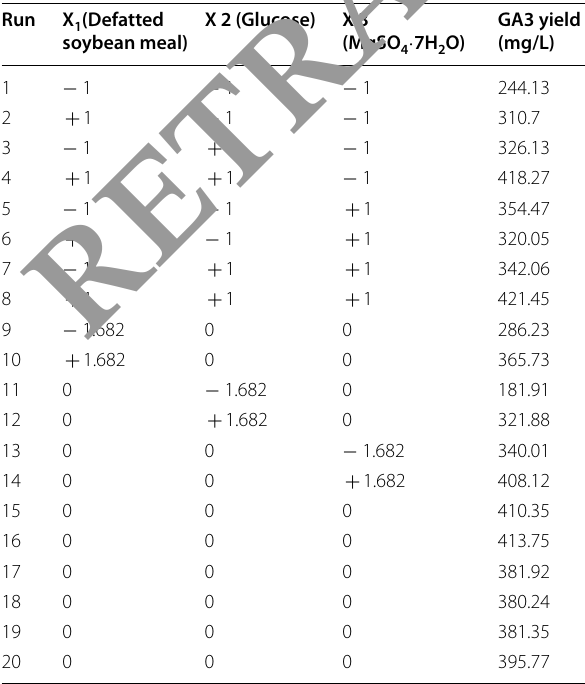
Table 6 Matrix of CCD and results of the response (GA3 yield) Run